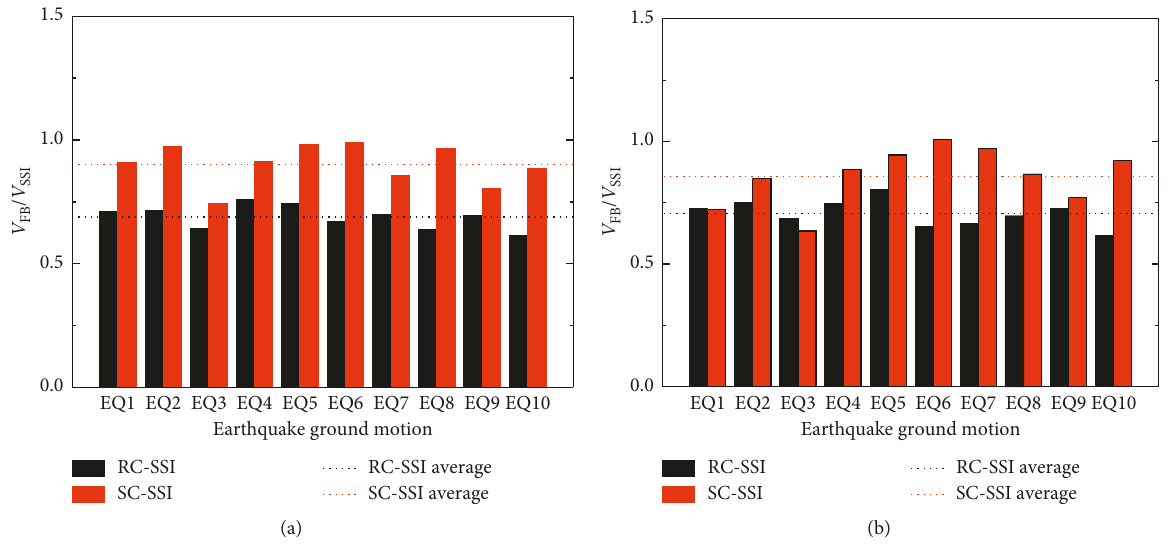
Figure 10: Base shear of the RC and SC frames with flexible foundations. (a) DBE. (b) MCE. Table 3: Damage classification criteria of foundations [41].